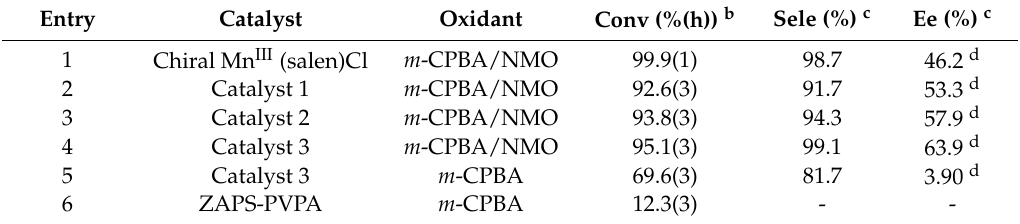
Table 1. Conversions and ee values for enantioselective for epoxidation of styrene catalyzed by chiral Mn III salen and catalysts 1–3 a .